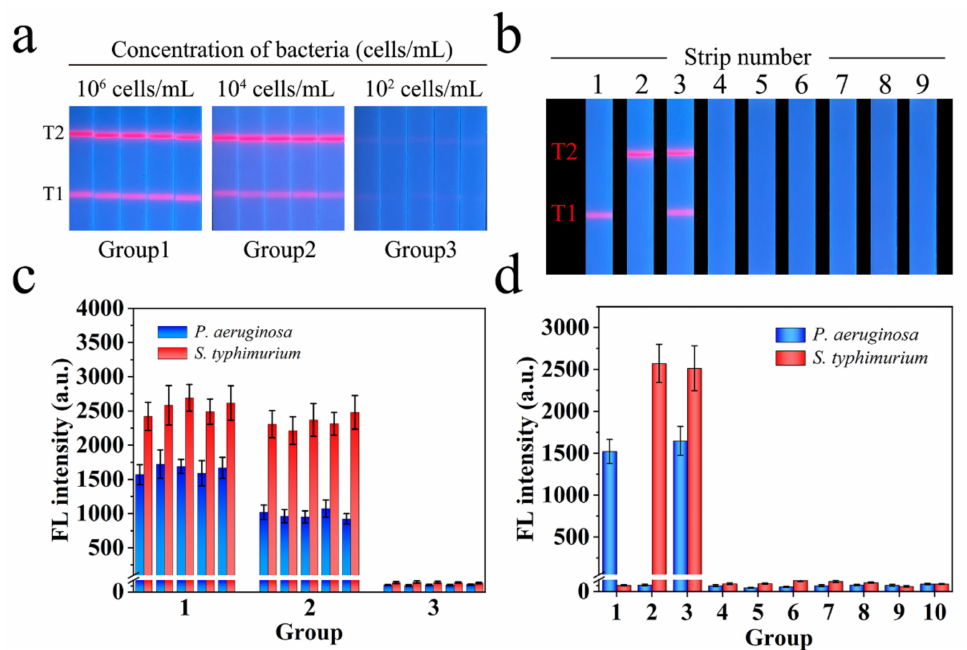
Figure 5. ( a ) Reproducibility of Mag@QDs-WGA-LFA for P. aeruginosa (T1) and S. typhimurium (T2). ( b ) Specificity of Mag@QDs-WGA-LFA. Groups 1–9 show the detection results for P. aeruginosa , S. typhimurium , P. aeruginosa / S. typhimurium mixture, Listeria monocytogenes , Staphylococcus aureus , Escherichia coli , Campylobacter jejuni , Shigella flexneri , and Vibrio parahaemolyticus . ( c ) Corresponding fluorescence intensities on the test lines of test strips in ( a ). ( d ) Corresponding fluorescence intensities on test lines of tested strips in ( b